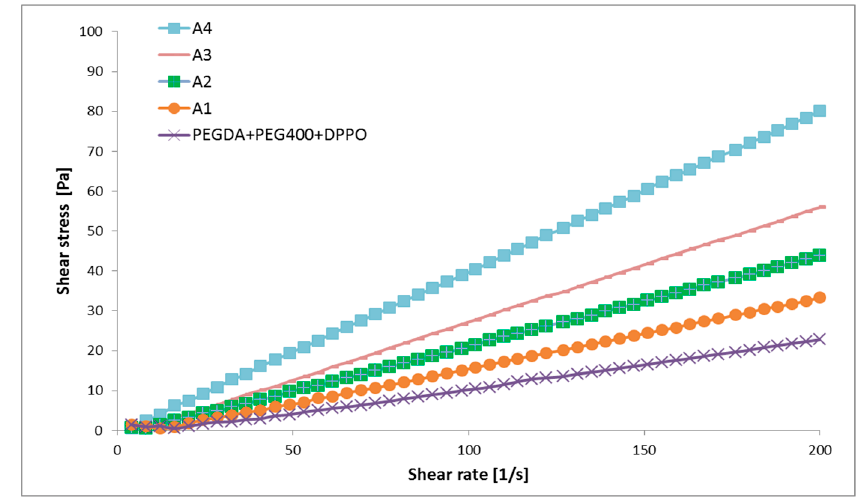
Pharmaceutics 2020 , 12 , x Figure 2. Flow curves of the placebo and the ATH suspensions. Figure 2. Flow curves of the placebo and the ATH suspensions.